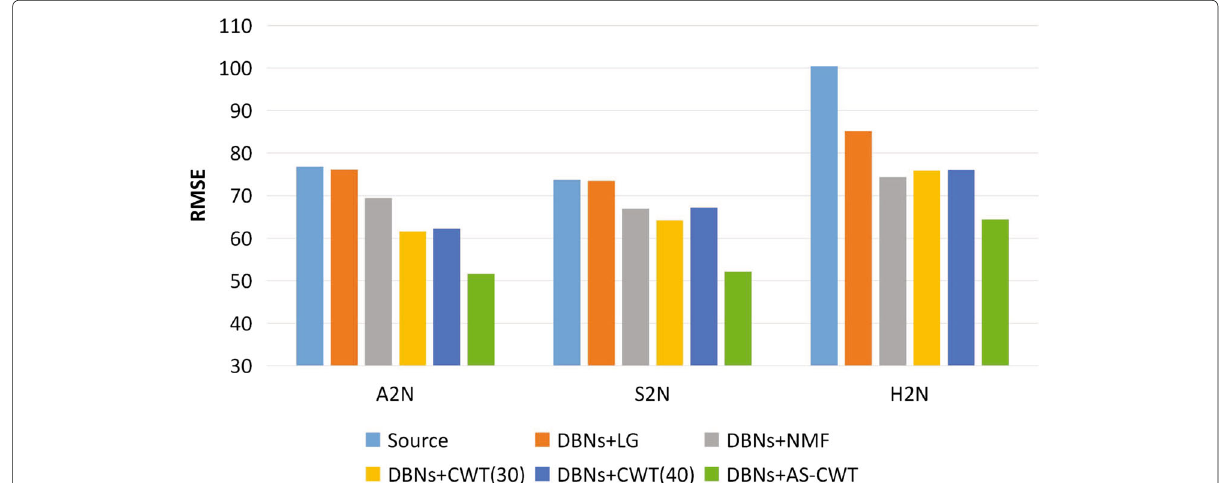
Fig. 10 Root mean-squared error evaluation of F0 features conversion from emotional to neutral